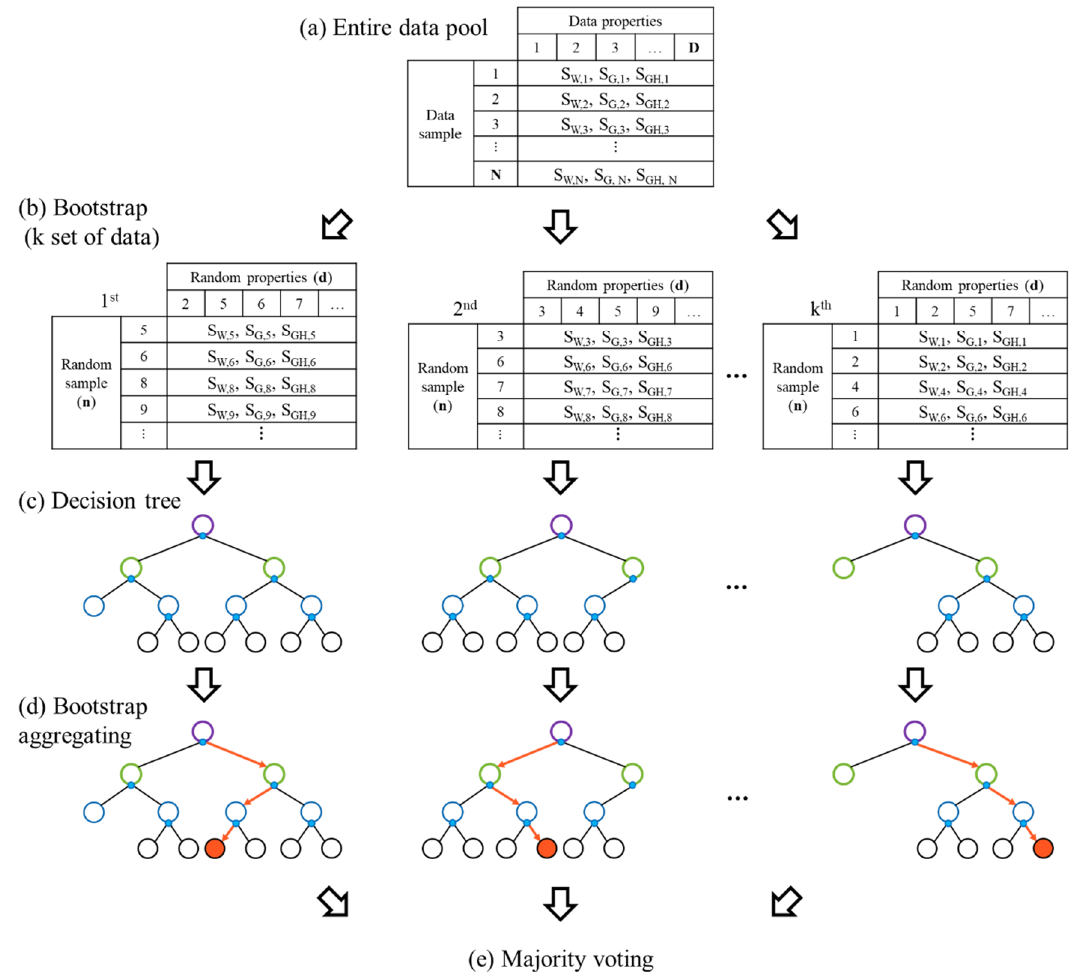
Figure 7. A random forest (RF) with multiple decision trees for the prediction of the target parameters.